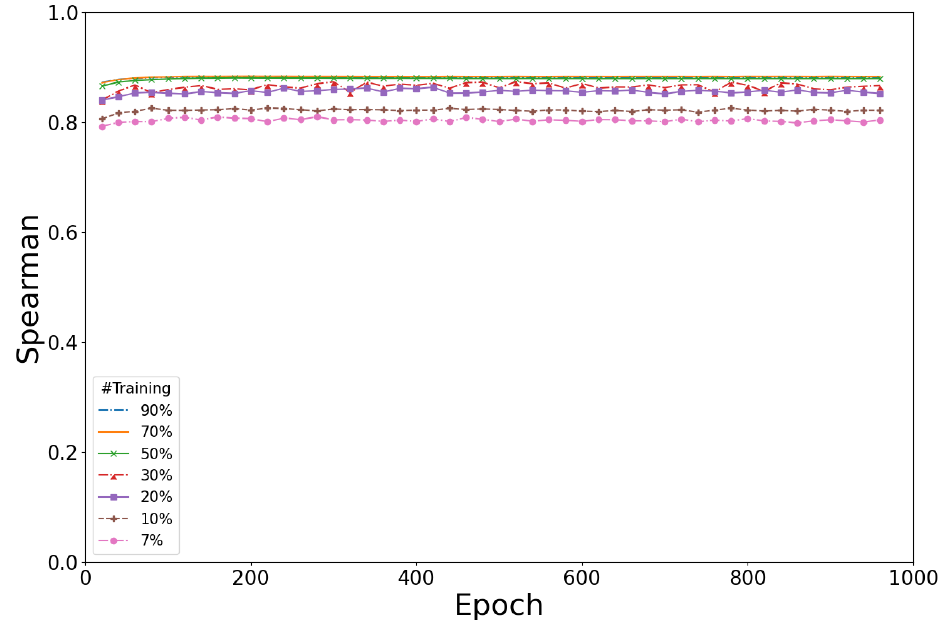
Figure 4. The sensitivity of Rep2Mut performance with the different numbers of training instances. X%: X% data are used to train Rep2Mut and (100-X)% for testing, and X is 90, 70, 50, 30, 20, 10, and 7 for different testing strategies. “#Training”: the numbers/percentages of training datasets.